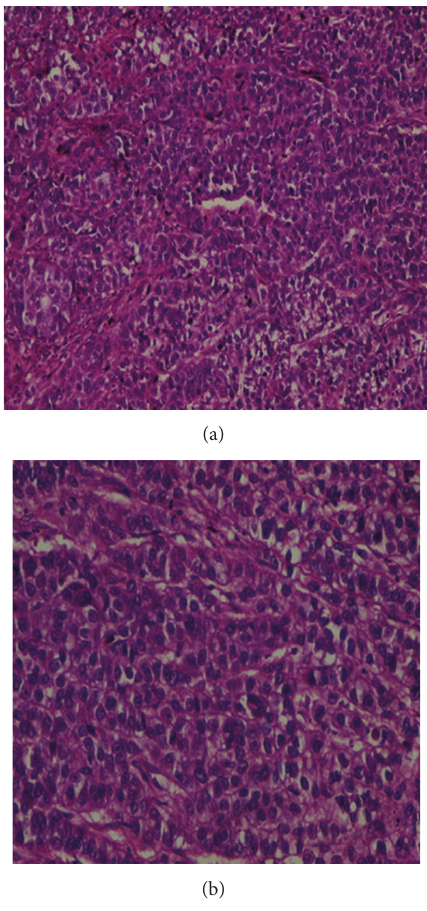
Figure 2: Histopathological findings. Lung adenocarcinoma metas- tasis. (a) Hematoxylin and eosin, × 200; (b) hematoxylin and Eosin, ×